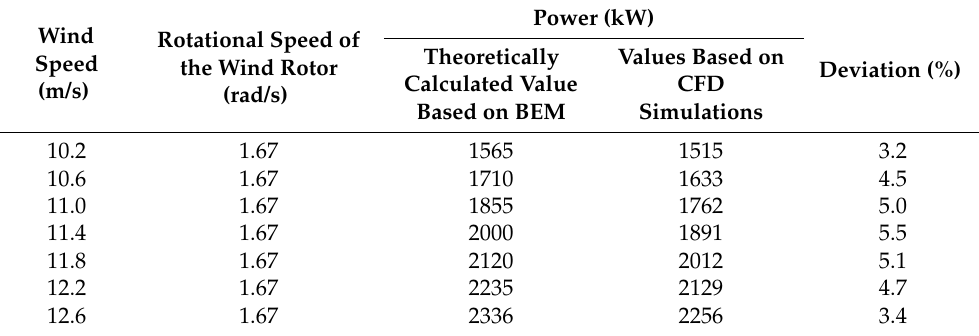
Table 5. Comparison of power calculation